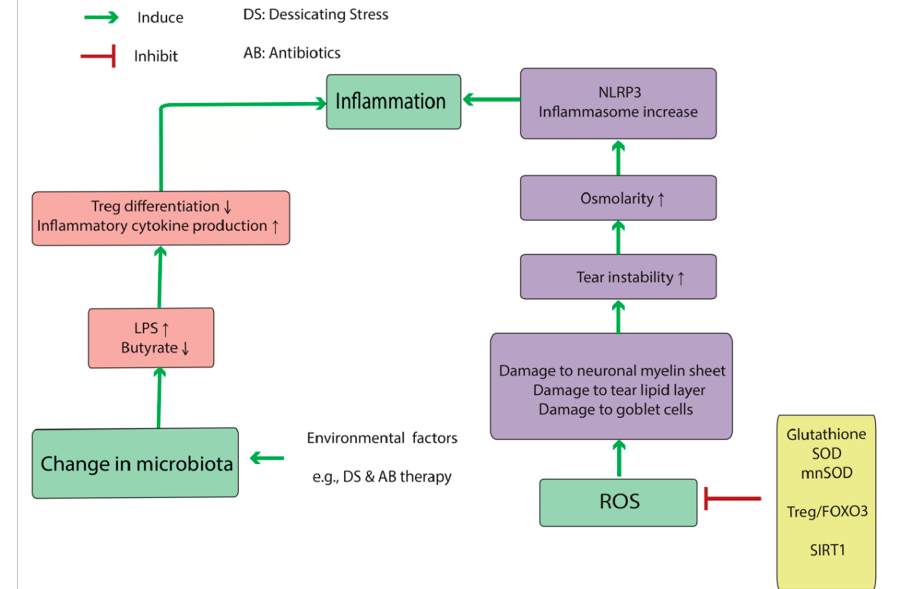
Figure 1. Oxidative metabolism and changes in normal microbiota contribute to dry eye disease (DED) by inducing inflammation at the ocular surface. Reactive oxygen species (ROS) directly or indirectly activates the NLRP3 inflammasome by increasing tear-film instability and osmolarity. DED-associated changes in the microbiota is in turn associated with changes in the metabolic profile of the ocular surface which changes the balance between pro- and anti-inflammatory arms of the immune system toward the proinflammatory pathways. The induced inflammation is